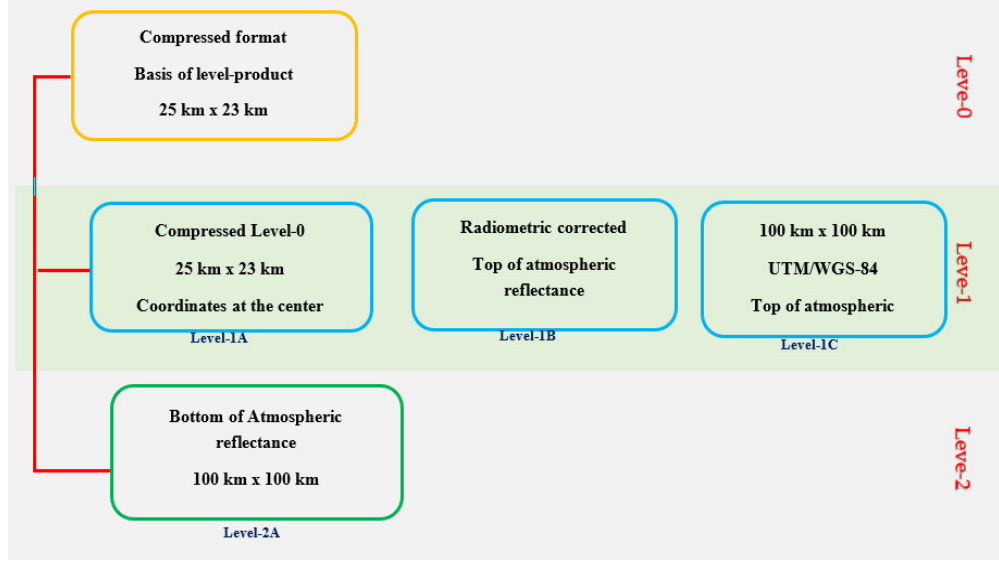
Figure 4. The processing levels and the format of Sentinel-2 data. It is important to note that the data undergoes different stages to get to level 2A, a form which is accessible and utilised by all the users